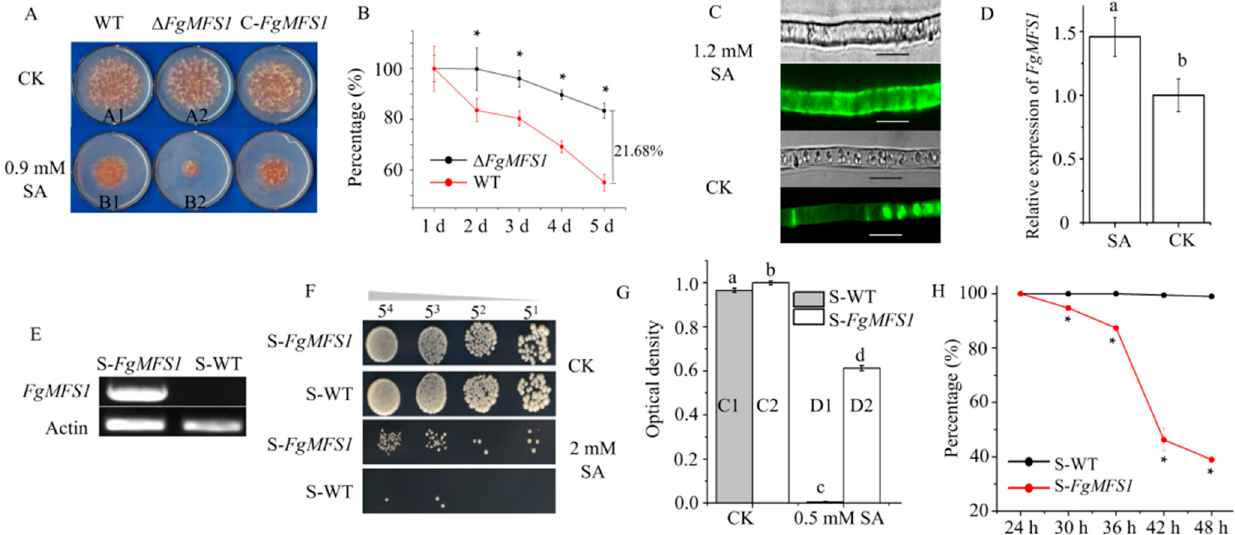
Figure 5. FgMFS1 encodes an SA exporter. ( A ) Mycelial growth on mSNA (modified Synthetischer Nährstoffarmer Agar) plates with and without SA. CK, control. Plates were photographed on the 4th d post inoculation (dpi). ( B ) Percentages of mycelial growth inhibited by SA ([A1-B1]/A1 for WT, [A2-B2]/A2 for ∆ FgMFS1 ). A1 (A2) and B1 (B2) indicate mycelial diameters of the WT ( ∆ FgMFS1 ) strain under the CK and SA treatments, respectively. Asterisks indicate significance at P < 0.01. ( C ) Subcellular localization of the FgMFS1 protein, scale bar, 10 µm. ( D ) SA induces the expression of FgMFS1 in the WT F. graminearum strain. ( E ) RT-PCR verification of the expression of FgMFS1 in yeast by using primer pair S- FgMFS1 -F + S- FgMFS1 -R (Table 1). Actin ( Actin -F + Actin -R) was used as the reference. ( F ) Yeast growth on dropout plates without uracil (DO Supplement-Ura) under SA and CK treatments, which were photographed on the 5th dpi. ( G ) Growth of S-WT and S-FgMFS1 strains in liquid DO Supplement-URA media with (0.5 mM) and without (CK) SA. Optical density was determined at 48 h after initial inoculation. ( H ) Percentages of growth inhibited by SA ([C1-D1]/C1 for S-WT, [C2-D2]/C2 for S- FgMFS1 ). C1 (C2) and D1 (D2) indicate the optical density of S-WT (S -FgMFS1 ) strain under the CK and SA treatments, respectively. Different small letters above each column indicate significance at P < 0.05. Asterisks indicate significance at P < 0.01.